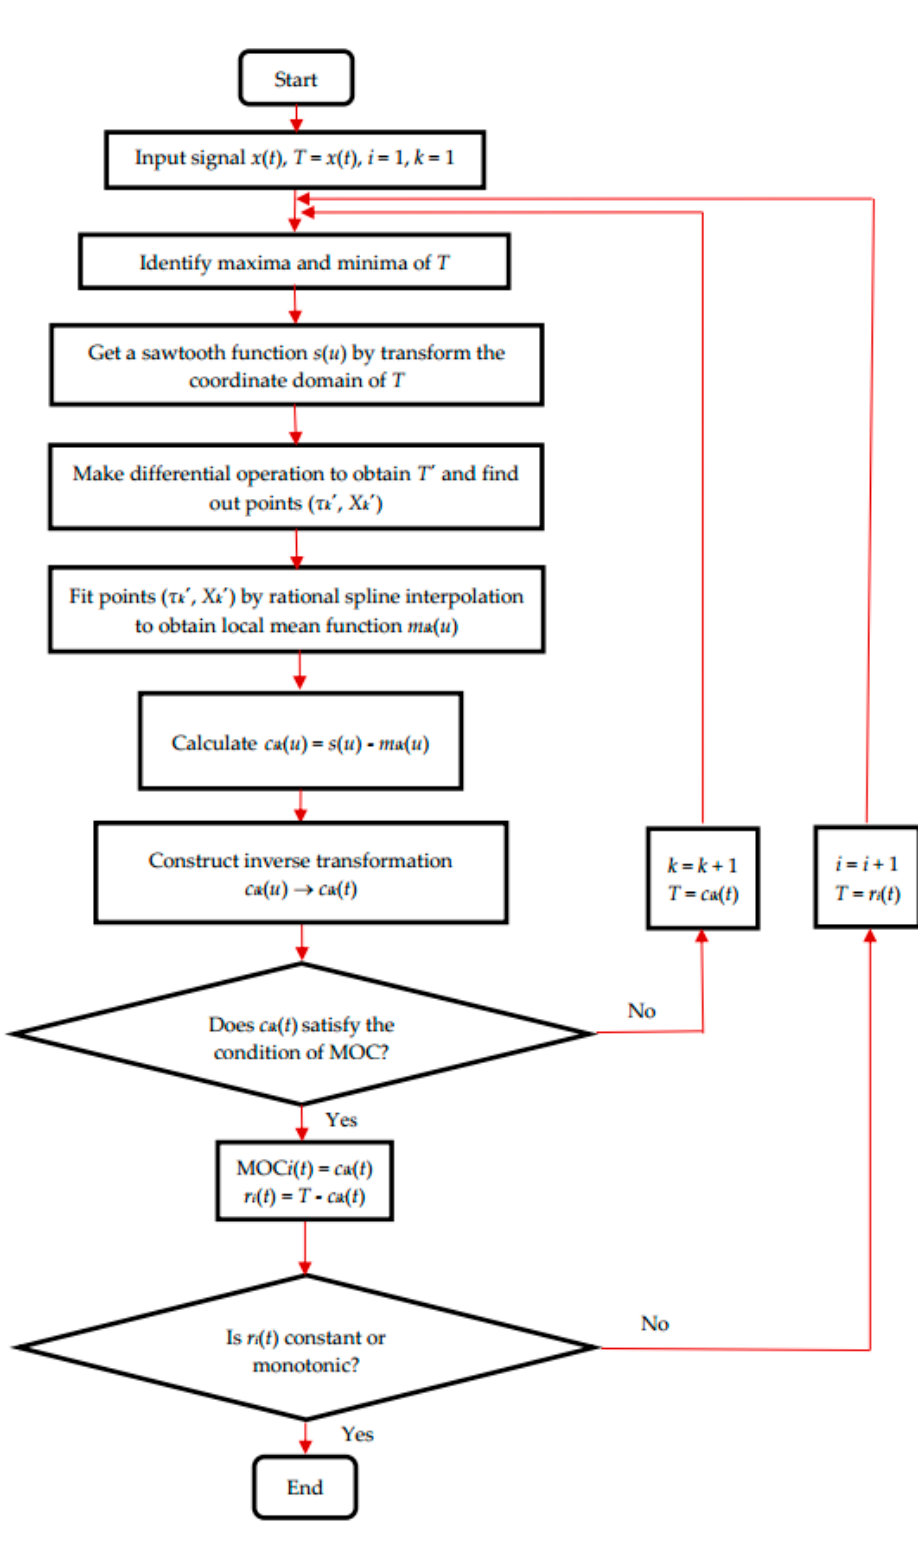
Figure 5. A flowchart of RS-LOD